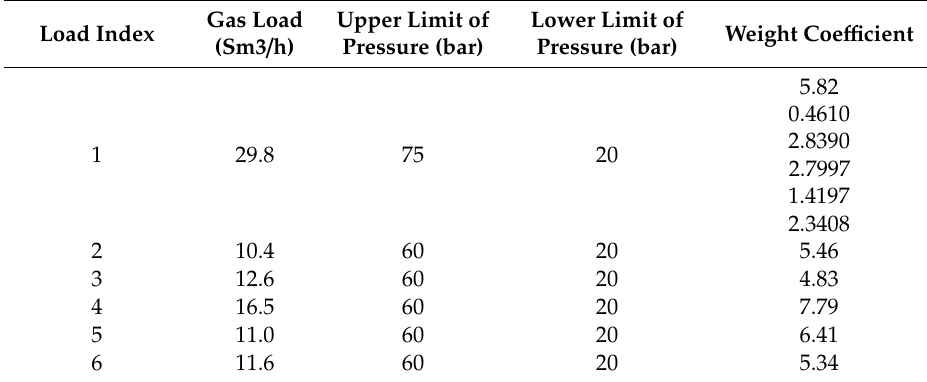
Table 4. Loads data of the natural gas network.